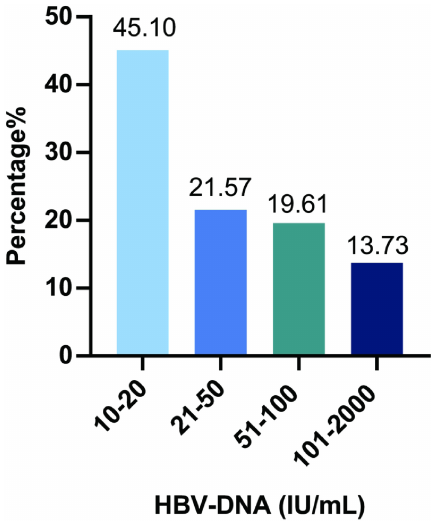
Figure 2. HBV DNA level distribution in CHB patients with LLV (n = 51). DNA was divided into 4 groups (10-20 IU/mL, 21-50